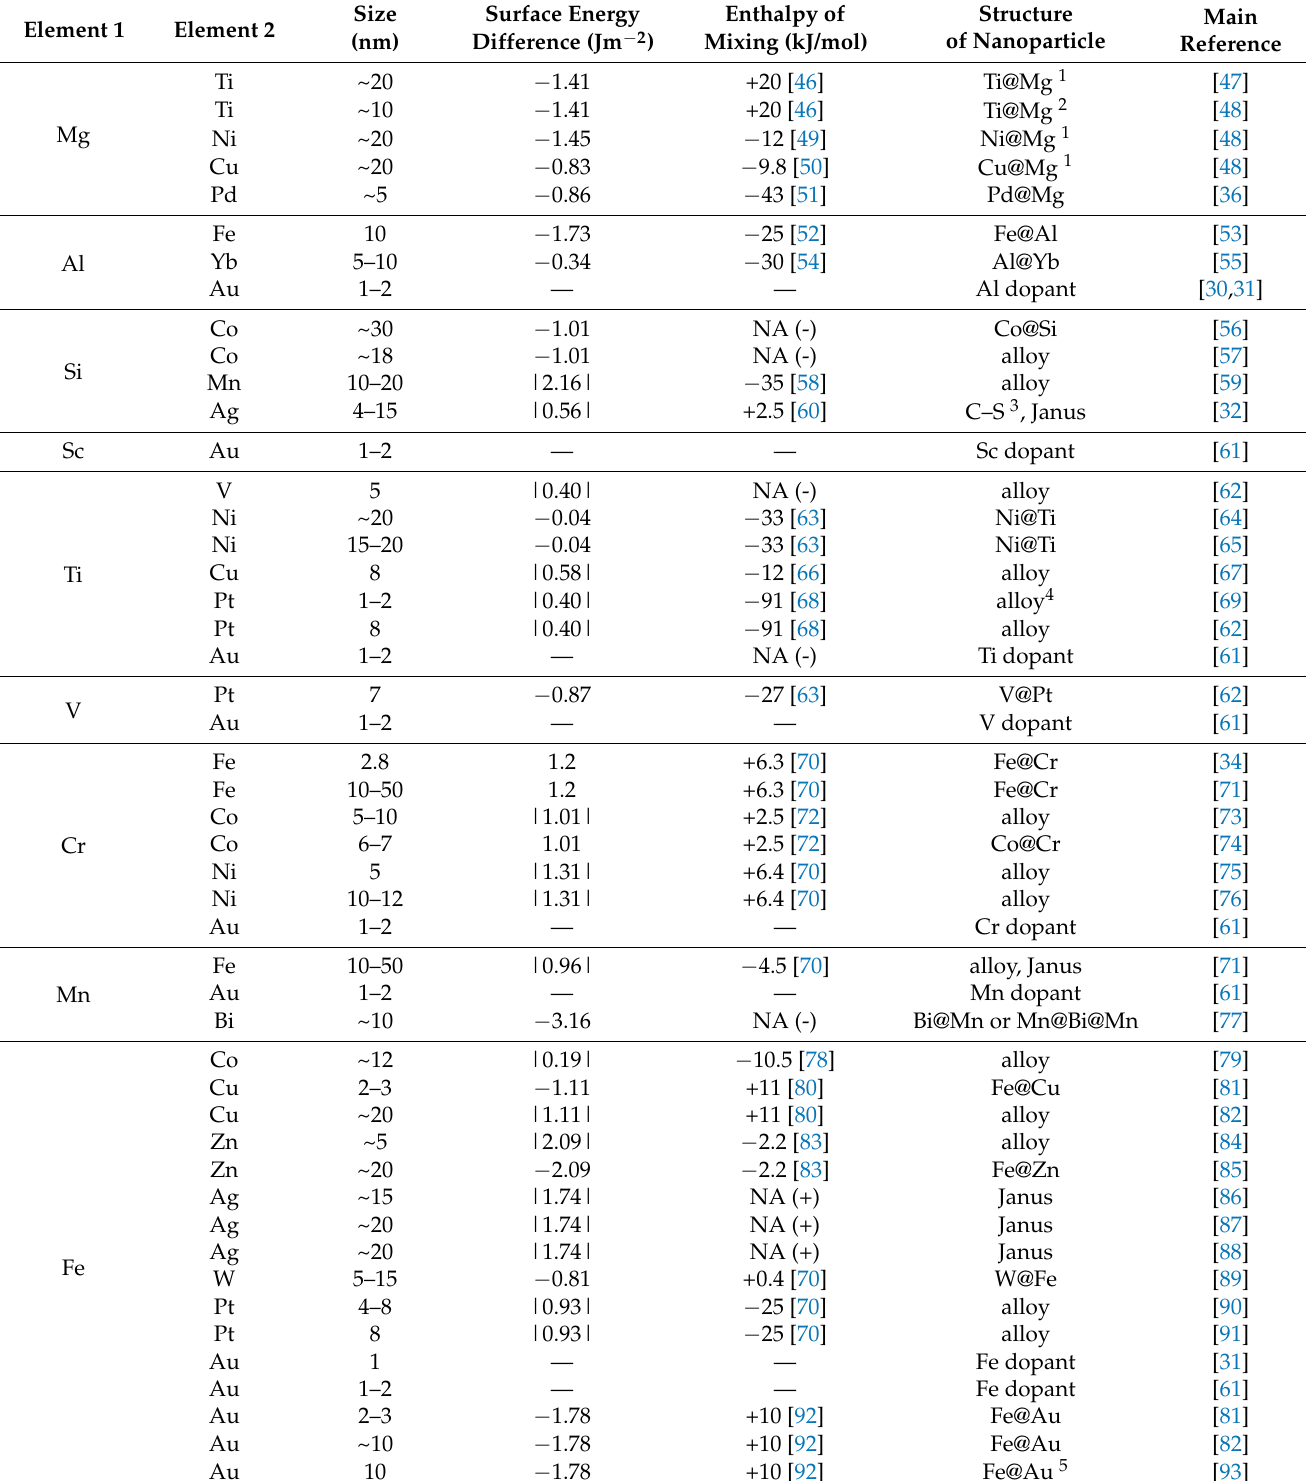
Table 1. List of two-element nanoparticles